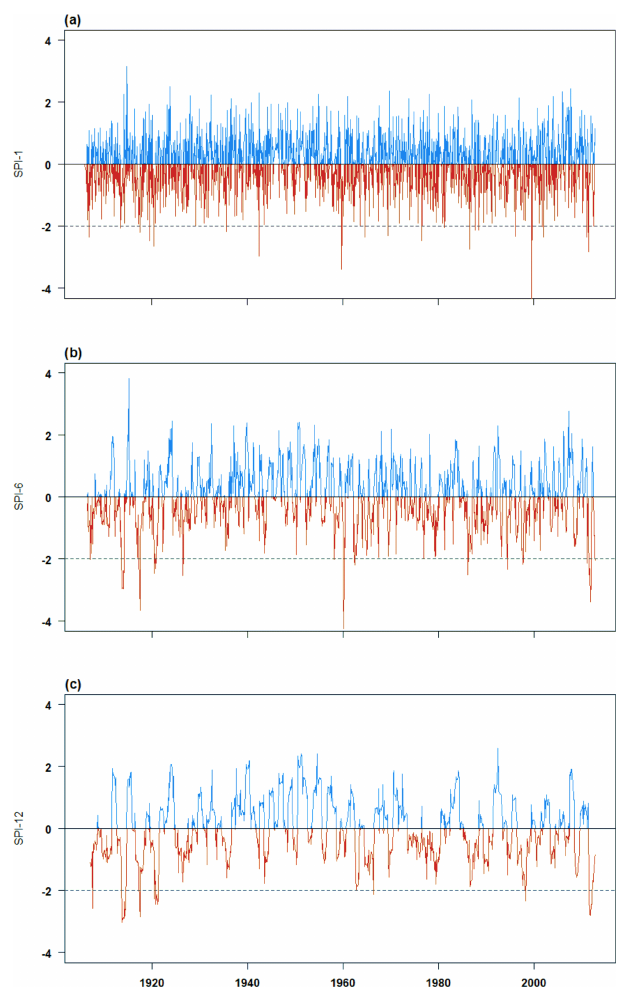
Figure 5. Standard precipitation index from 1906 to 2015, with wetter (blue) and drier (red) than normal conditions indicated for (a) SPI-1, (b) SPI-6 and (c)